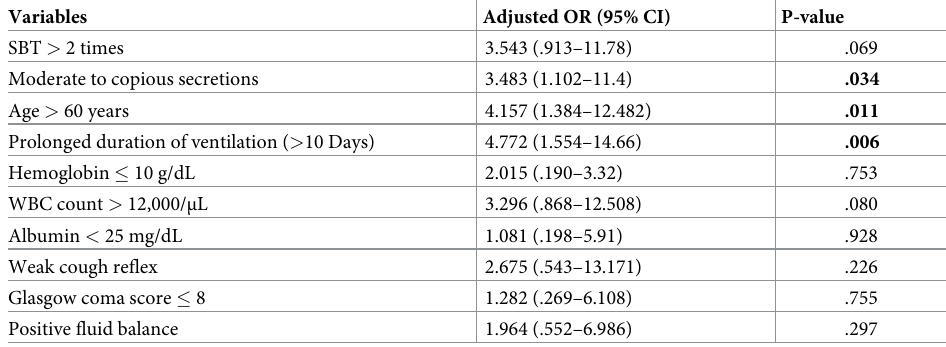
Table 4. Multivariate logistic regression analysis showing predictors associated with extubation